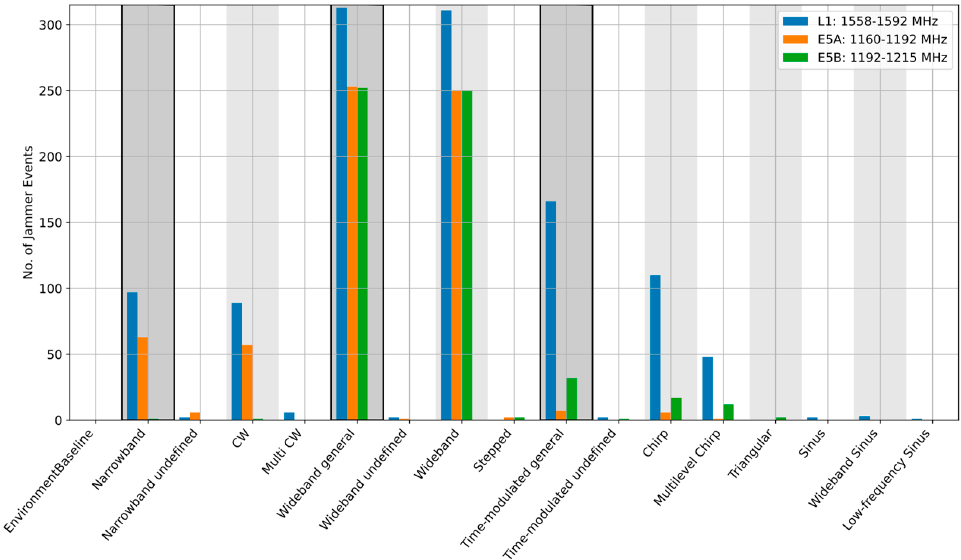
Figure 4. Detailed classification results, Asker station, Norway, 2020.